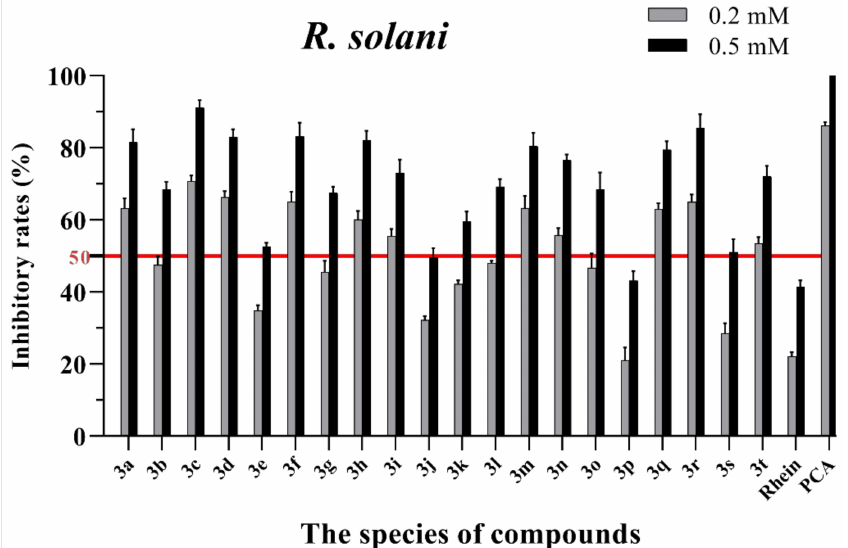
Figure 3. Mycelial growth % inhibition of chemicals against R. solani . The bold red line is the identity line with the inhibition rate of